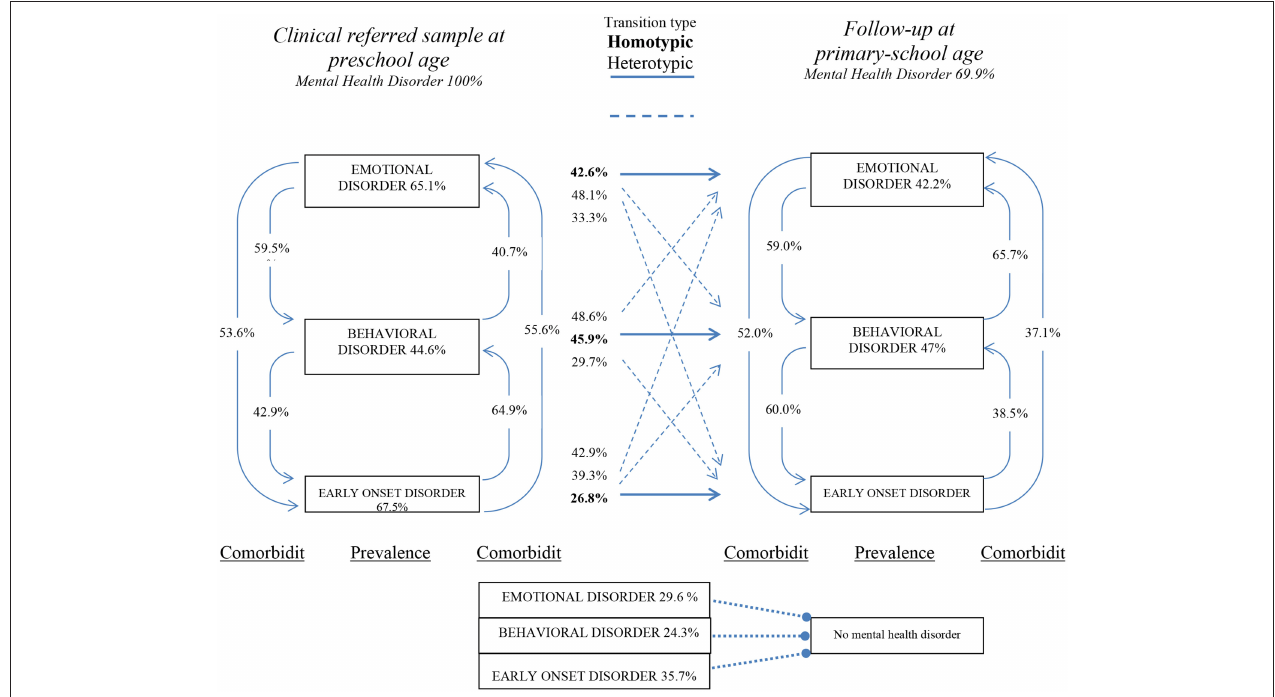
FIGURE 1 | Percentage of children showing a disorder in one of three disorder clusters (ED, BD, SEO) at admission and follow-up, comorbidities between disorder clusters at preschool (left side) and primary-school age (right side), and transition types (center: homotypic or heterotypic). N = 83. Any heterotypic development is indicated by a dashed line, while a solid line indicates homotypic